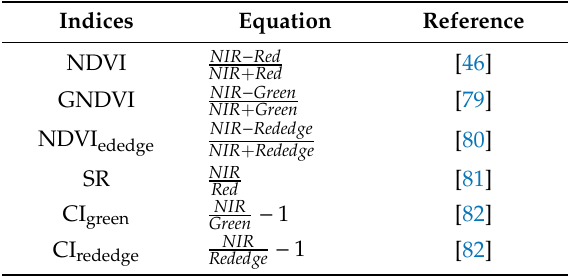
Table 2. List of vegetation indices (VIs) and their formulas used in this